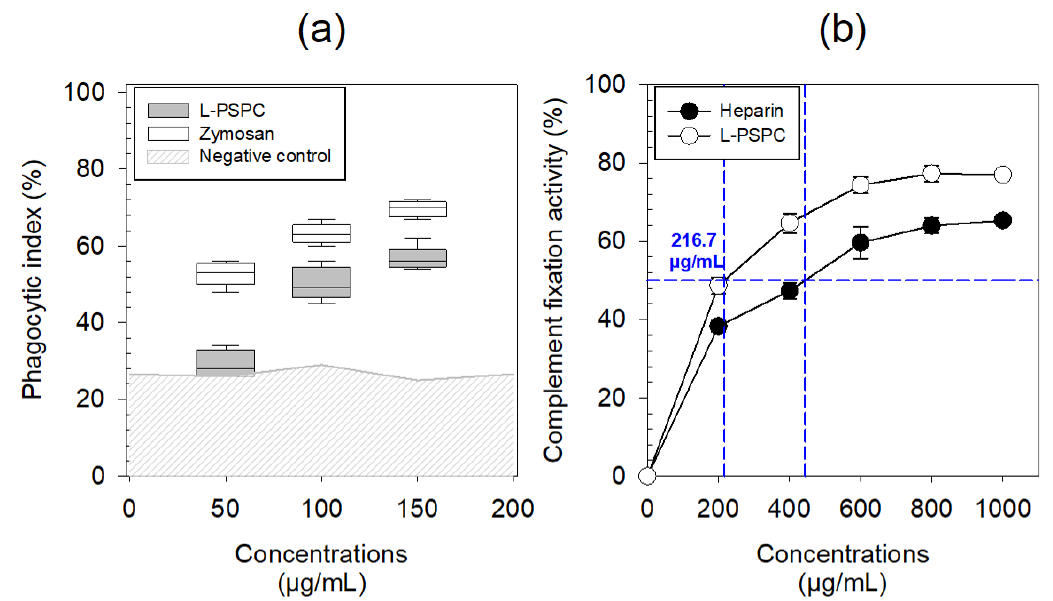
Figure 4. Biological effects of L-PSPC on ( a ) phagocytosis activity of polymorphonuclear leukocytes by the uptake of opsonized C. albicans and ( b ) complement fixation. 372